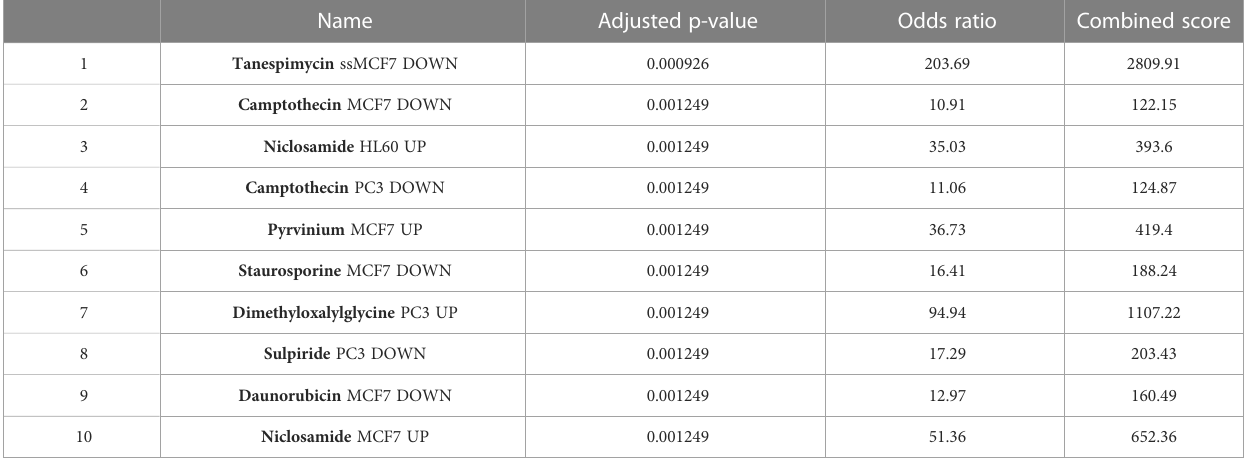
MCF and PC3 represent different cell lines. Adjusted p-value<0.05 has a statistical difference. AKI, acute kidney injury; CKD, chronic kidney disease.